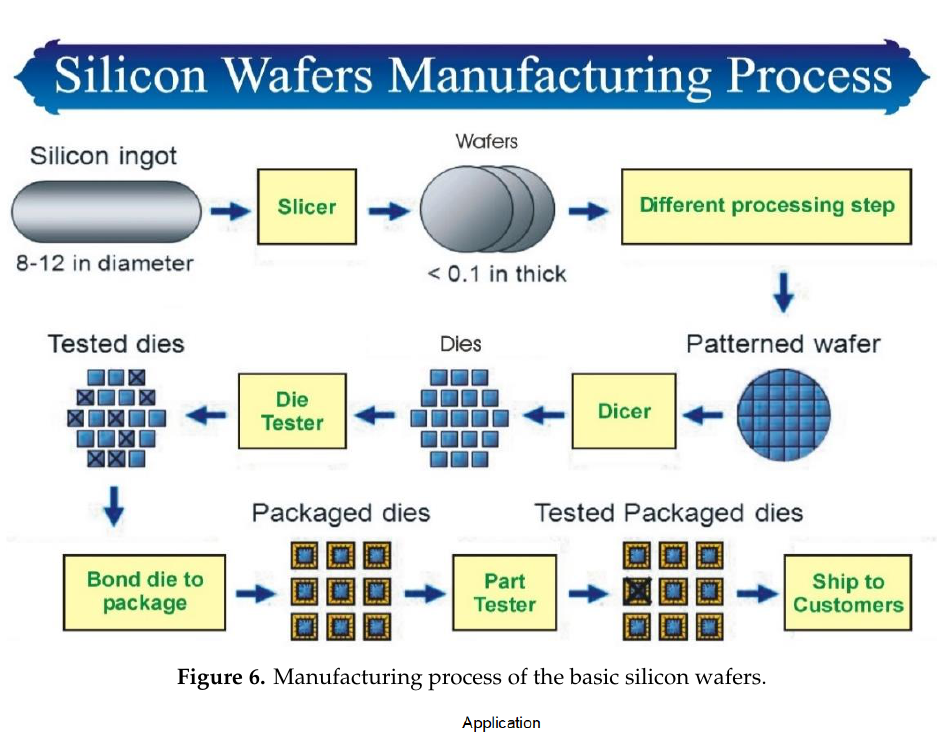
Mathematics 2020 , 8 , x FOR PEER REVIEW Figure 6. Manufacturing process of the basic silicon wafers. Figure 6. Manufacturing process of the basic silicon wafers.